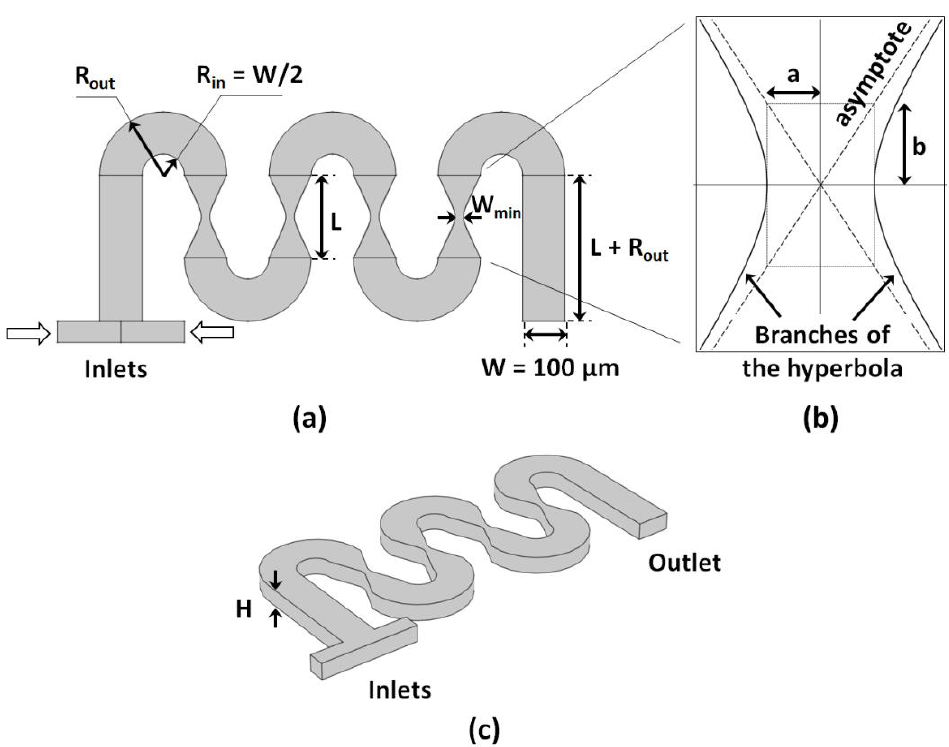
Figure 2. ( a ) Top view of the geometry of the investigated design; ( b ) hyperbola defining the constriction of the straight sections between adjacent curves; ( c ) 3D geometry of the channel investigated.